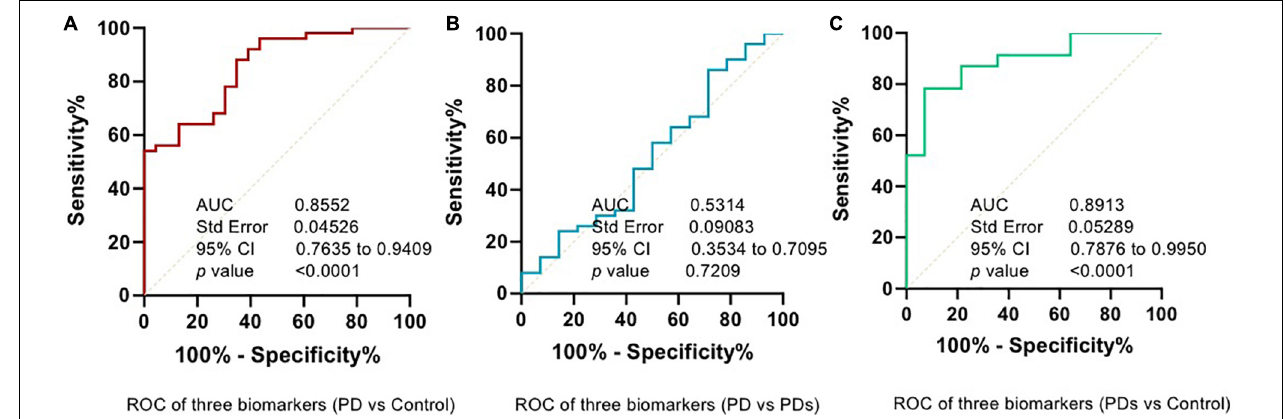
FIGURE 4 | Combined assessment of a panel of plasma p-Asyn at ser129, total α -syn, and oligomeric α -syn is a better biomarker for Parkinson’s disease. (A) ROC curve of combined biomarkers between PD and HCs; (B) ROC curve of combined biomarkers between PD and PDs; (C) ROC curve of combined biomarkers between PDs and HCs.